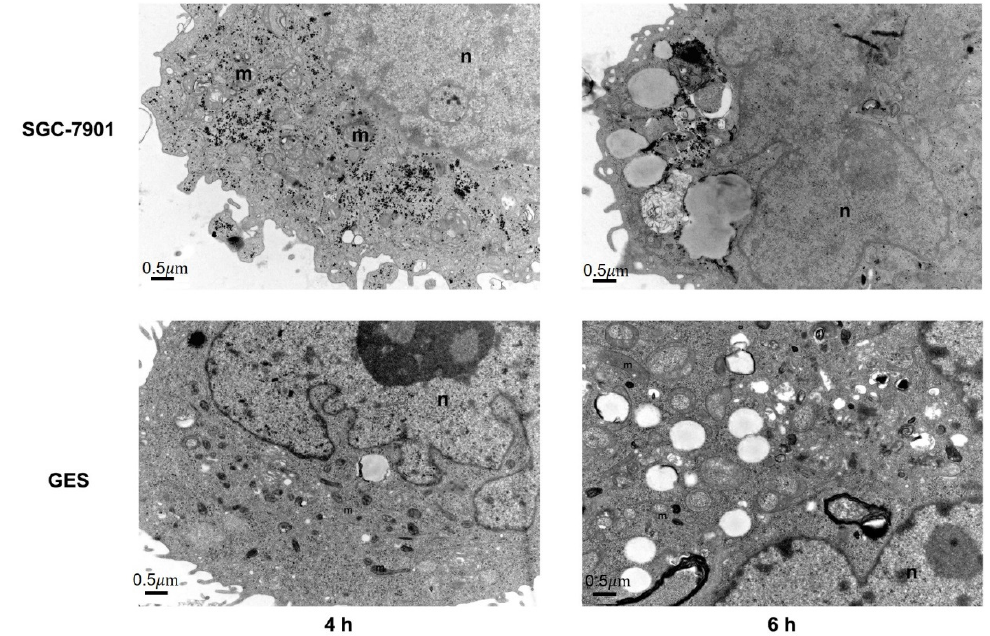
Figure 7. The transmission electron microscopy images of PEG-AuS on SGC-7901 and GES-1 cells after treatment with PEG-AuS for 4 h or 6 h.